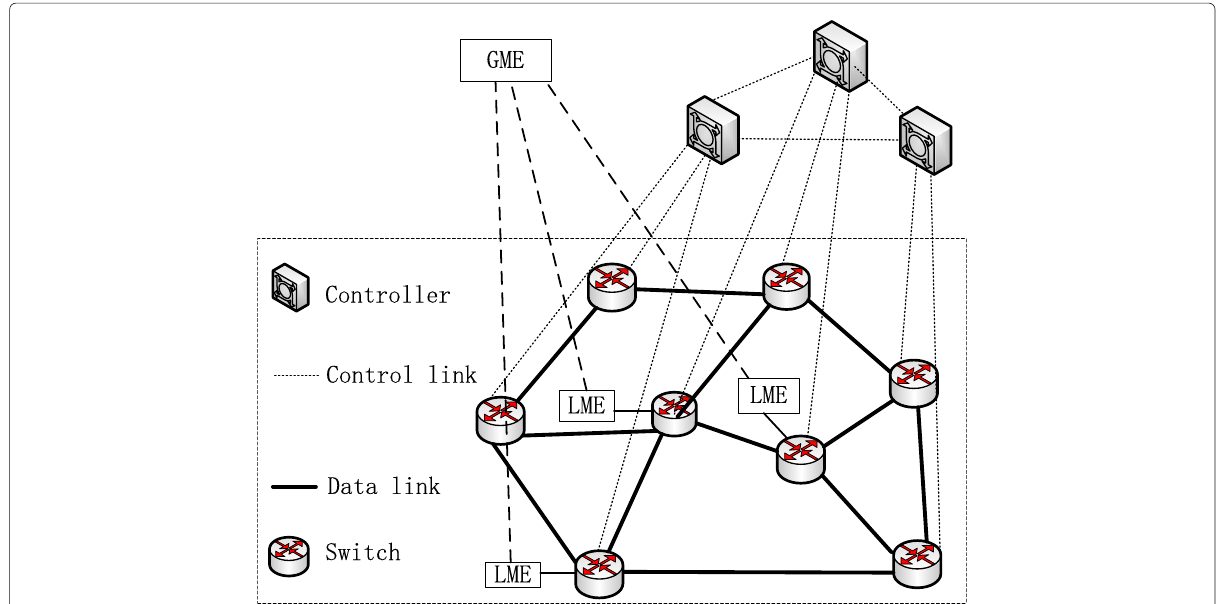
Fig. 2 Proposed SDN Hierarchical Management Architecture. The proposed SDN hierarchical management architecture based on which the proposed capacity controller deployment scheme can be